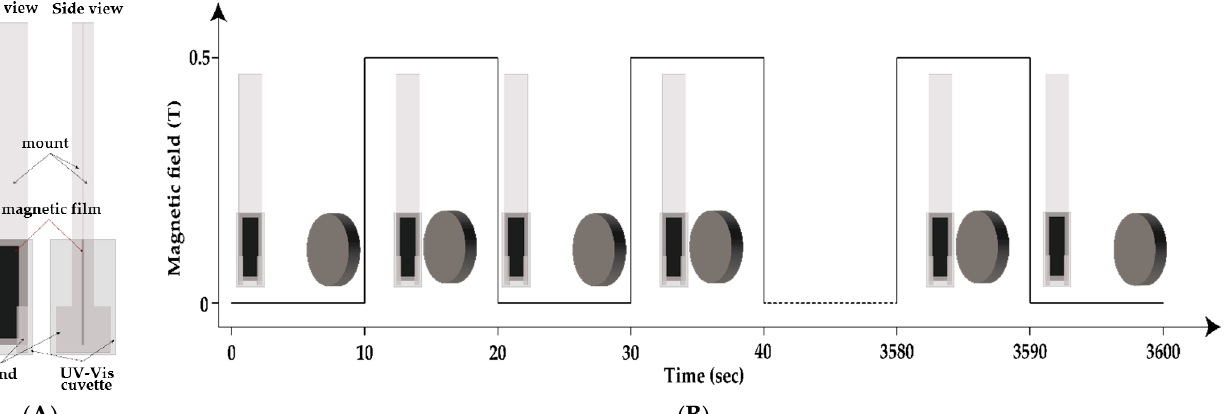
Figure 1. ( A ) PMMA mount placed in a UV-Vis cuvette. ( B ) Experimental set-up used to study the outcome of applying a magnetic field in triggering folic acid release at pH = 8 via a magneto-mechanical trigger. The digital signal representation corresponds to the switching state of the magnetic field, where the high peaks indicate the magnetic field is on, while the low peaks stand for the off state of the magnetic field.